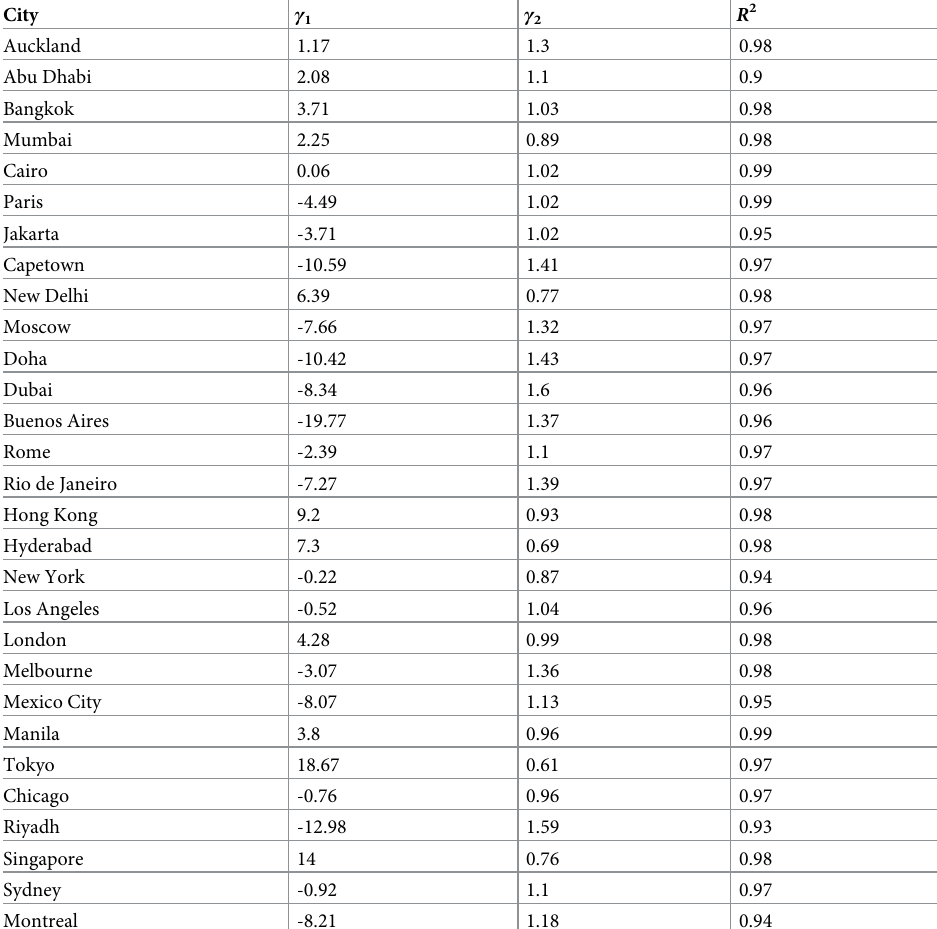
Table 2. Spatial dispersion regression